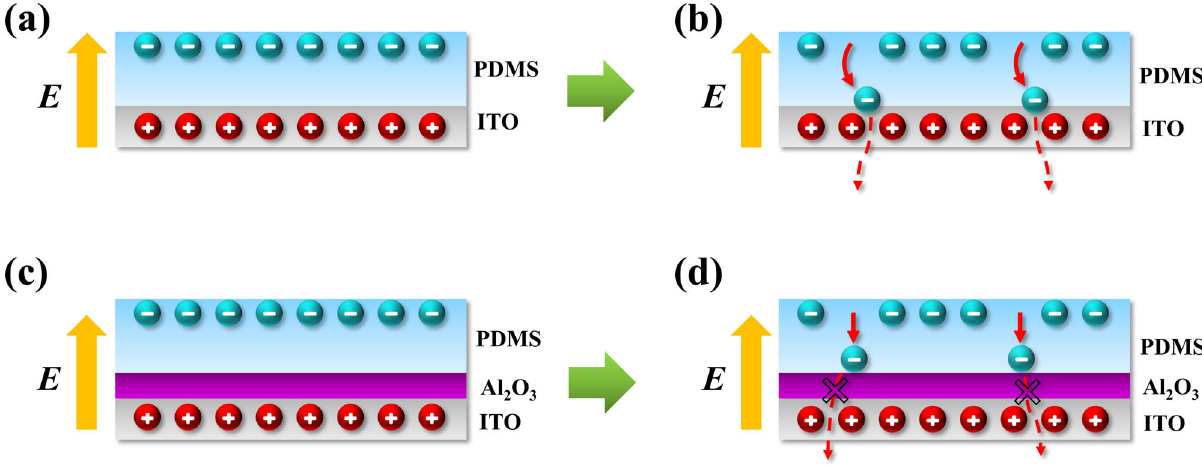
Figure 6: Working principle of the Al 2 O 3 electron blocking layer. Schematic diagram of ( a ) the charge distribution and ( b ) electron drift process in the TENG without Al 2 O 3 . Schematic diagram of ( c ) the charge distribution and ( d ) the electron drift motion blocked by the Al 2 O 3 layer in the TENG with an inserted Al 2 O 3